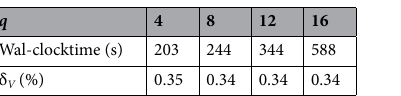
x ) at N D (cid:31)